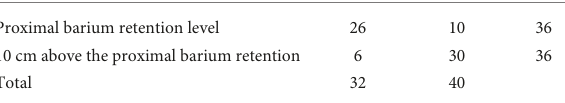
TABLE 6 Diagnostic test characteristics for predicting dysganglionic bowel segment in infants using a 24-h delayed film of barium enema.